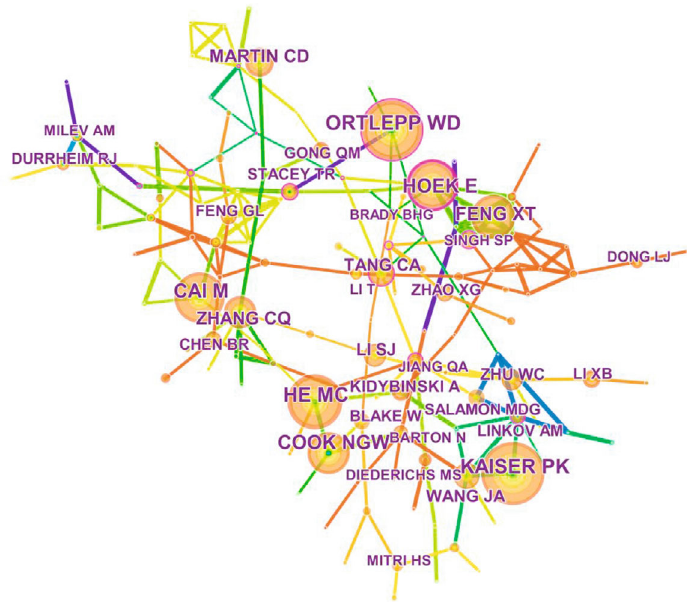
Figure 12: Author cocitation